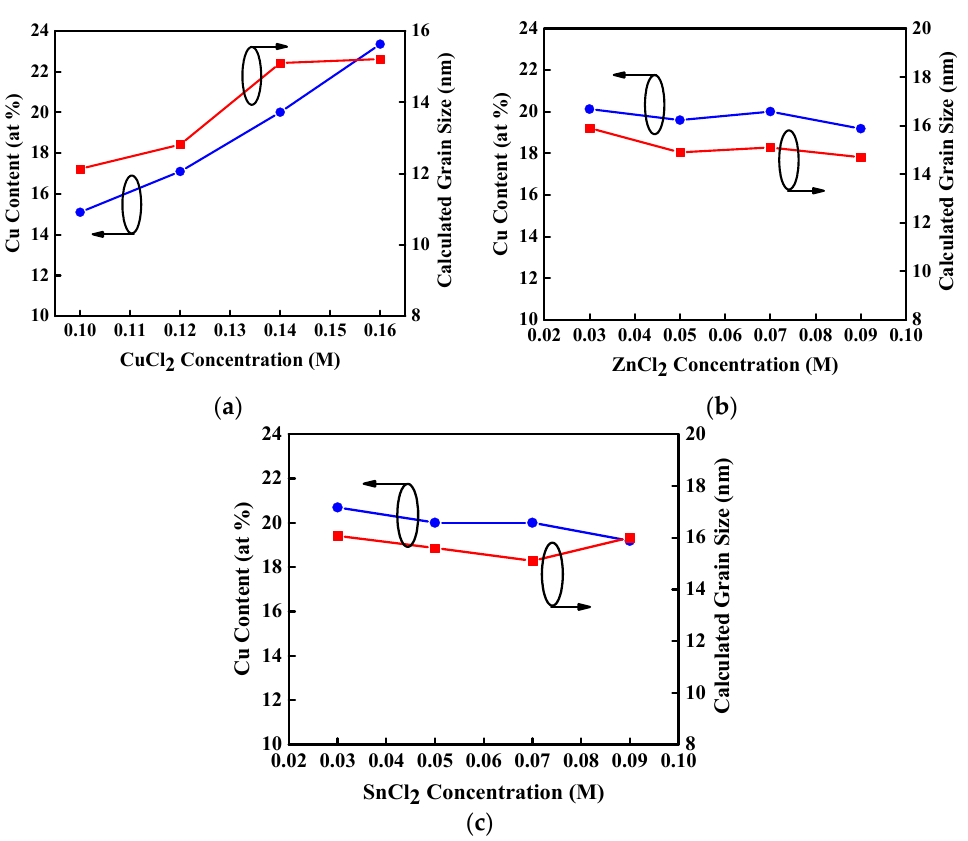
Figure 3. Full width at half maximum (FWHM) of (112) peak and calculated grain size for CZTS thin films with varied concentration of ( a ) CuCl 2 ; ( b ) ZnCl 2 ; and ( c ) SnCl 2 aqueous precursor solution under an annealing temperature of 350 °C.